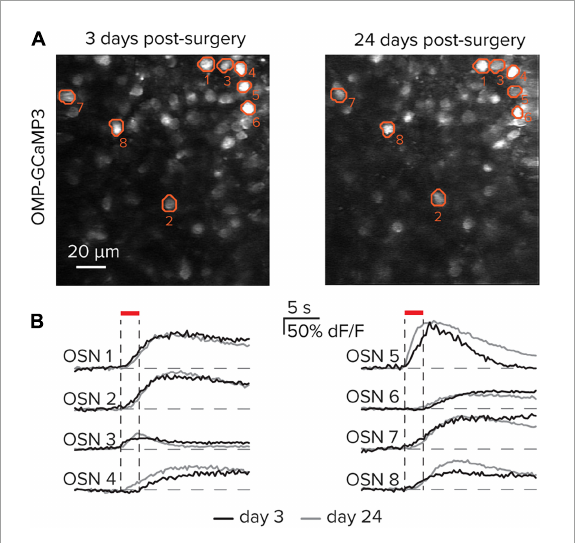
FIGURE4 Longitudinal imaging of olfactory sensory neurons. (A) The same imaging field in the olfactory epithelium 21 days apart. A subset of eight cells is identified in each image. (B) Functional responses from the eight identified cells in part (A) on post-surgical days 3 and